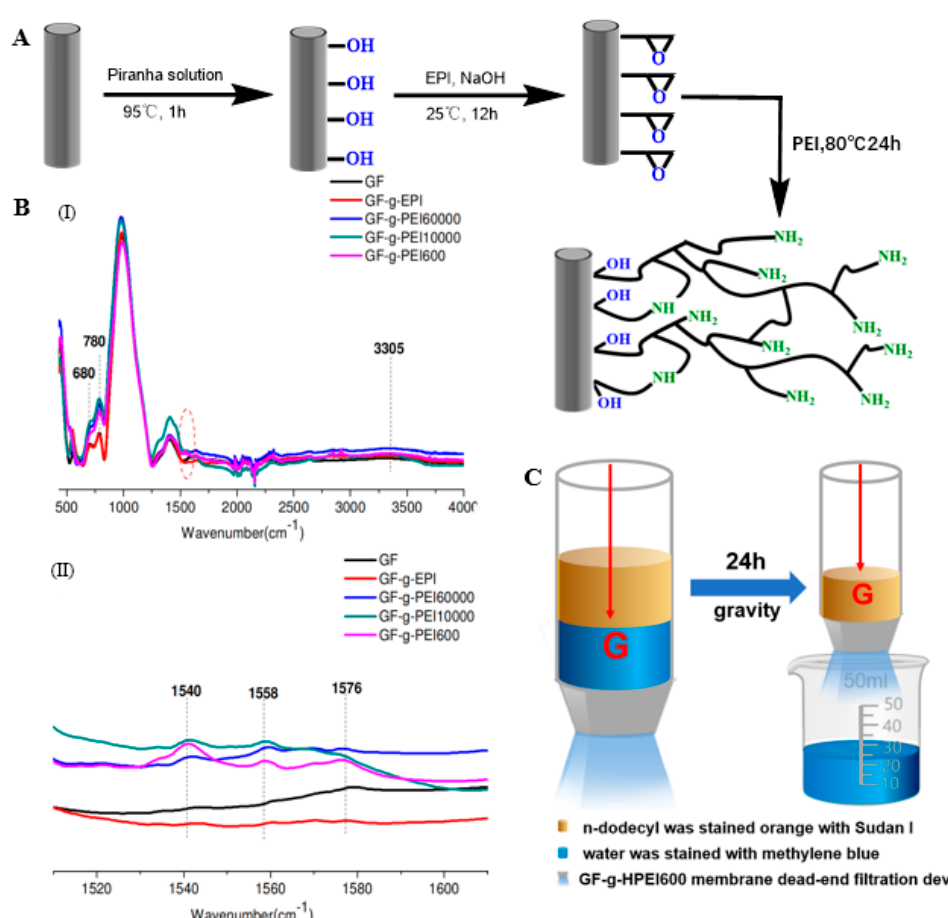
Figure 14. ( A ) Reaction mechanism of HPEI grafting onto glass fiber membrane surface. ( B ) ATR-FTIR spectra of GF, GF − g − EPI, GF − g − HPEI60000, GF − g − HPEI10000, and GF − g − HPEI600 mem-